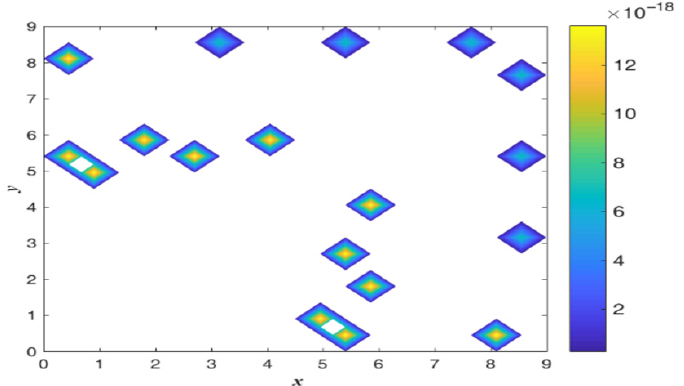
Figure 18. The absolute error distributions for a nonlinear Helmholtz problem under E xyz = 10 14